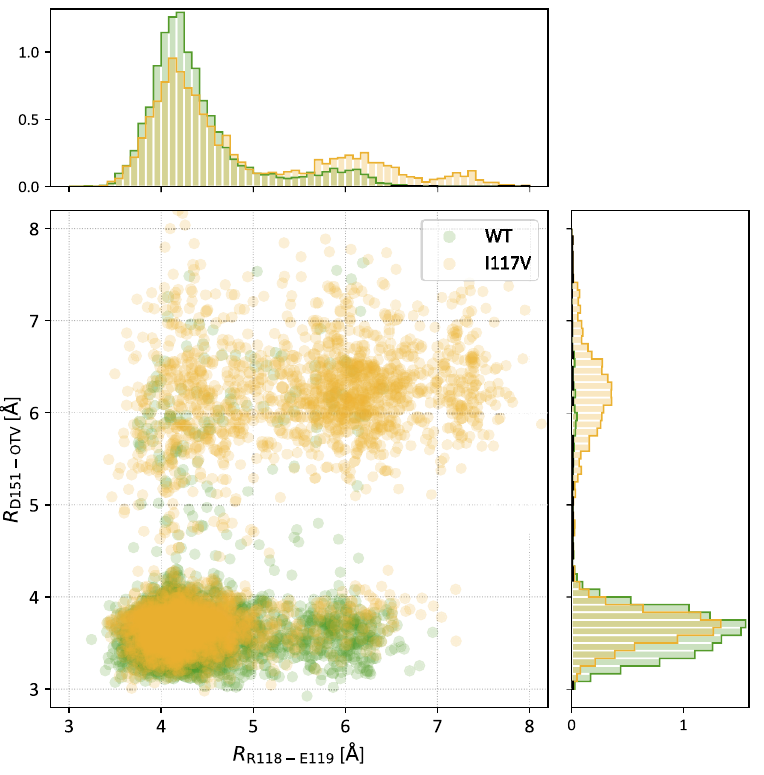
Figure 4 Correlations between residue-residue and residue-drug interactions. Scatter plots and probability densities for the distance of the R118-E119 pair ( R R118-E119 ) versus the distance of the D151- OTV pair ( R D151-OTV ) in the wild-type (WT) and I117V mutant NA-OTV complexes.